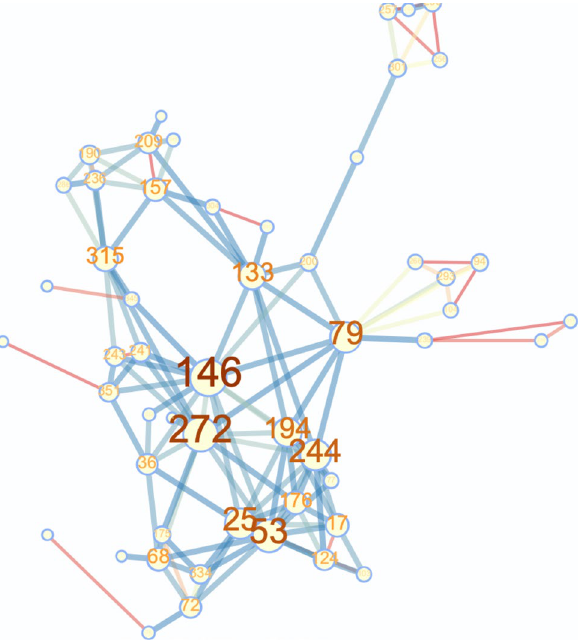
Figure 7. An example misinformation network with 50 nodes (misinformation